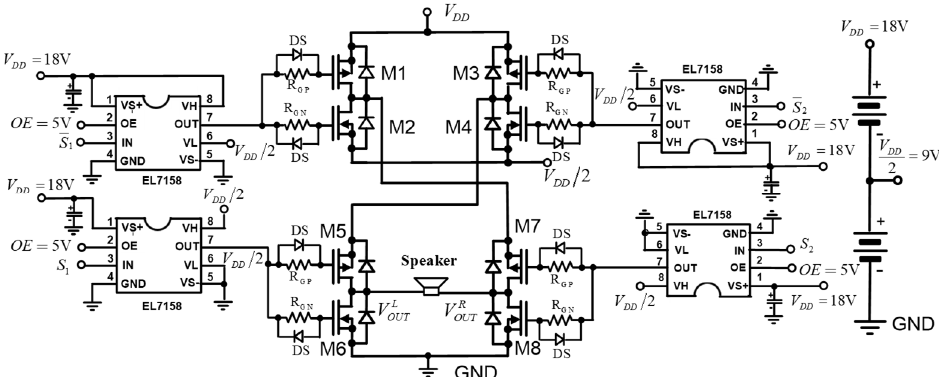
Figure 5. Circuit diagram of filterless, digital Class-BD amplifier with balanced CM output, implemented on complementary pairs of MOSFETs and four ultrahigh-current EL7158 pin drivers.